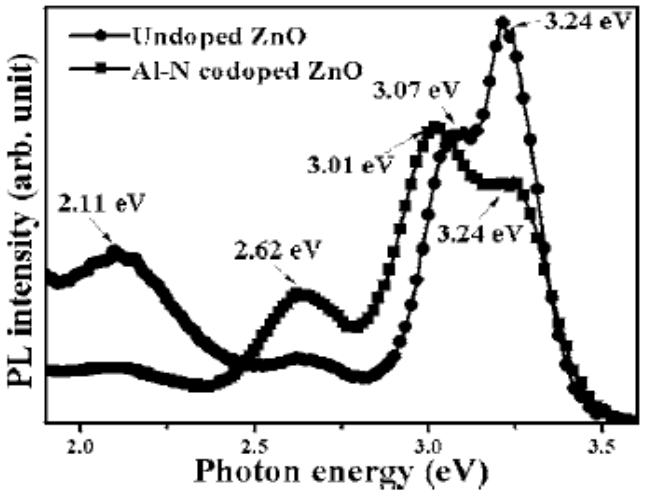
Figure 14. Room temperature PL spectra of the Al–N codoped [theoretical Al atomic ratio of 10%] and undoped ZnO films deposited on silicon substrates annealed at 400 °C under nitrogen ambient for 30 min. Reprinted from Ref. [20] with